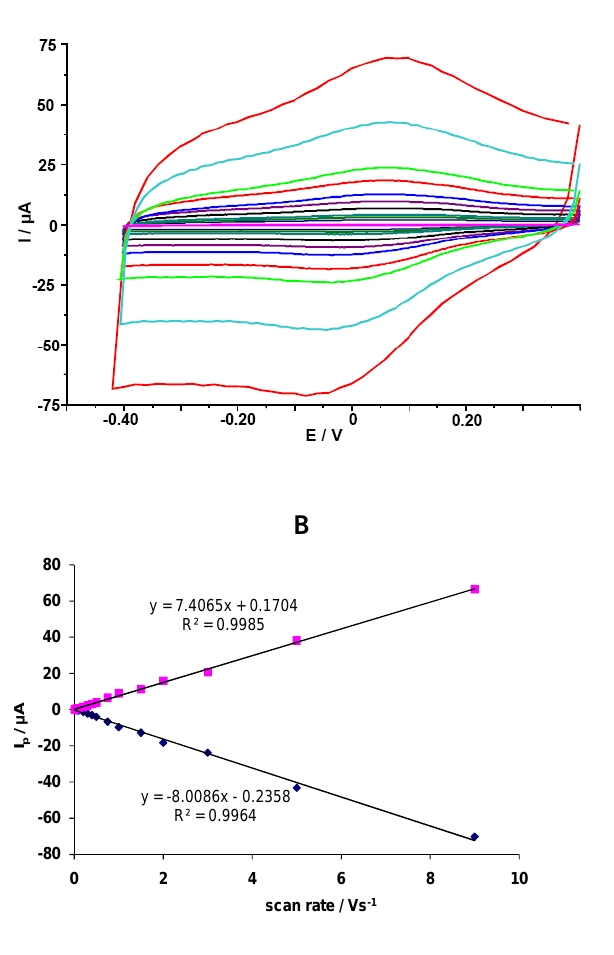
Figure 1. (A) The CV curves for GCE/SWCNT/Hb measured in solution containing NaCl 0.05 M and acetate buffer 0.2 M pH = 5.0 vs scan rates: 0.01, 0.02, 0.03, 0.04, 0.05, 0.075, 0.1, 0.2, 0.3, 0.4, 0.5, 0.75, 1.0, 2.0, 3.0, 5.0, 9.0 V/s. (B) Linear relationship between cathodic and anodic peak current vs . scan